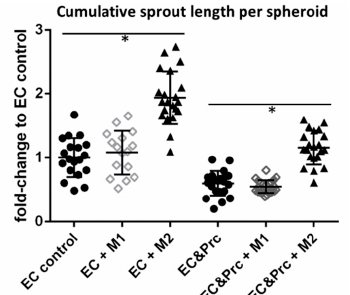
Figure 3. Endothelial cell (EC) sprouting assay in the presence of polarized macrophages. EC spheroids with and without pericytes (Prc) (circle) were induced to sprout suspended with M1(rhombus) and/or M2 macrophages (triangle). Quantification of cumulative sprout length per spheroid normalized to EC control. Results are displayed as scatter plots with mean ± standard deviation; n ≥ 16. * indicates a p -value < 0.05.